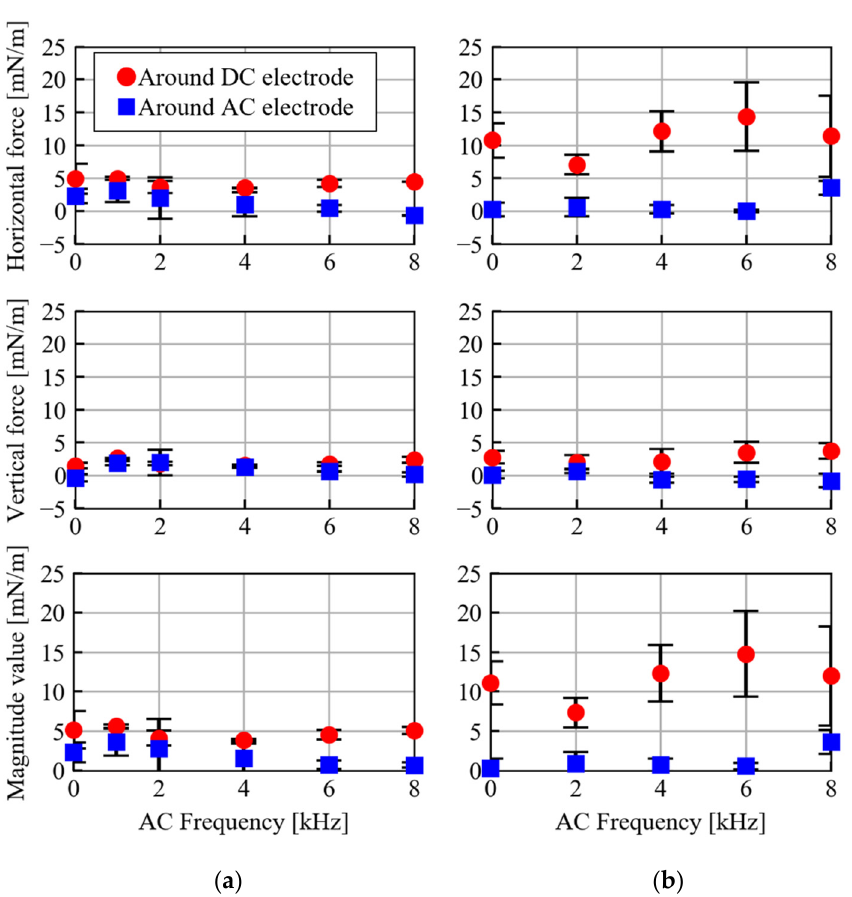
Figure 22. Momentum flow rate versus the frequency of the AC voltage when the AC voltage was 10 kV pp and the DC voltage was 14 kV in the ( a ) CD-PA and ( b ) TED-PA.